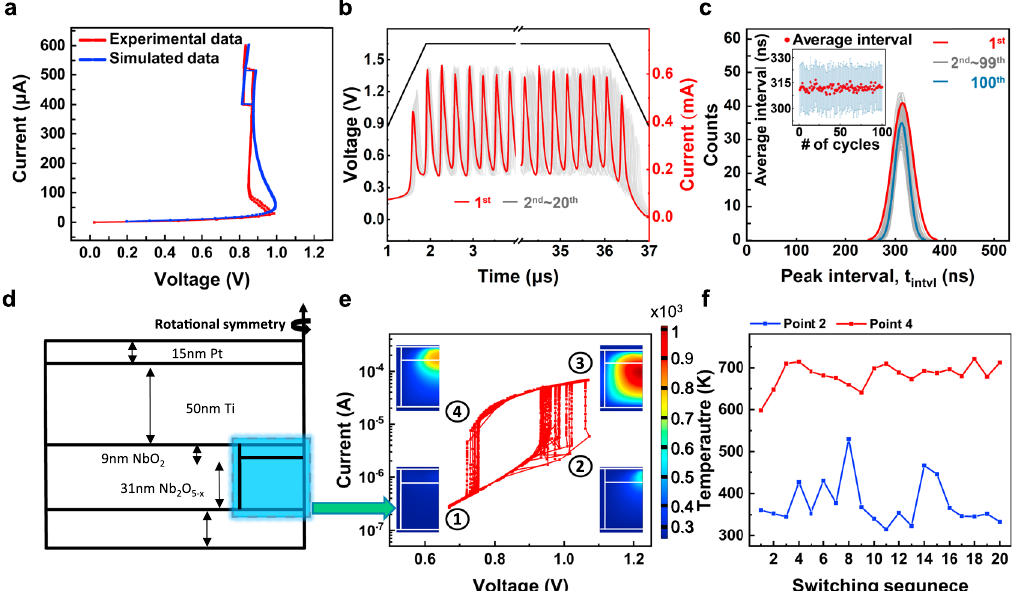
Fig. 2 Simulations of stochastic oscillation characteristic induced by thermal fl uctuation. a A numerically simulated I – V curve (blue) compared with an experimental one (red line). b Simulated 20 oscillation currents (red and gray) under a fi xed voltage input (black). The oscillation outputs overlap well at the beginning, but they disperse at the end. c Simulated distributions of the peak intervals for 100 cycles. Inset shows an average and a standard deviation of intervals. The results reproduce the experimental results in Fig. 1e. d A geometry used for a thermodynamic simulation, which is identical to the fabricated device in Fig. 1a. e Simulated I – V curves from the thermodynamic simulation under a sinusoidal input voltage. The insets show heat distribution at each moment. f The maximum temperatures at the moment of switch on ( ② , blue) and switch off ( ④ , red) for 20 cycles of simulation, showing they fl uctuate.